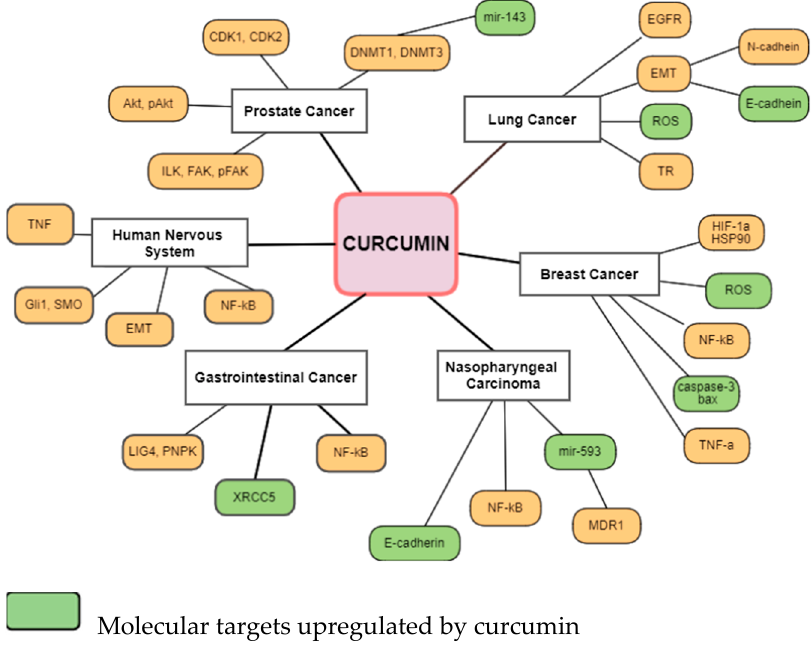
Figure 2. Molecular targets of curcumin contribute to radiosensitization in different cancers. Abbre- viations: CDK: cyclin-dependent kinase; Akt: protein kinase B; ILK: integrin-linked kinase; FAK: